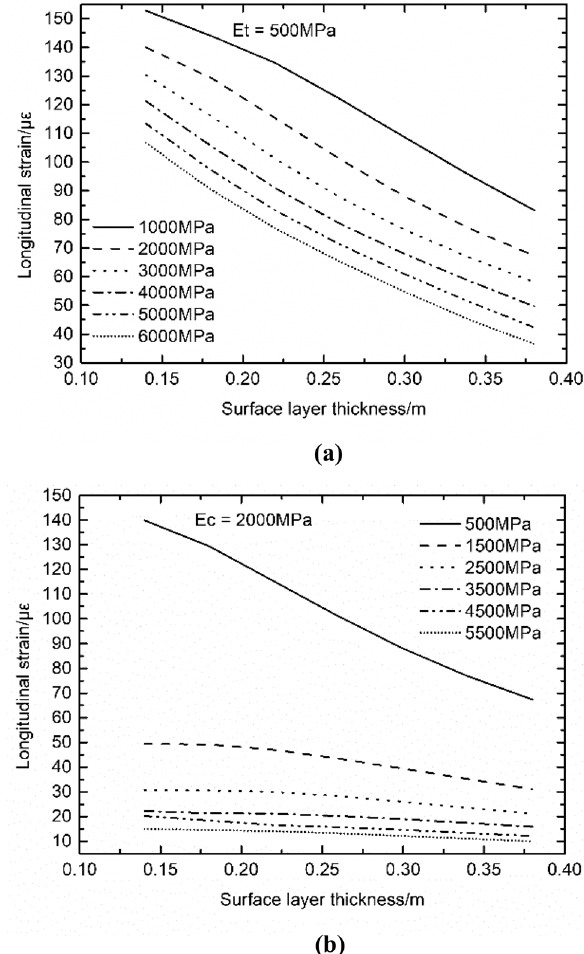
Fig. 7 Response of longitudinal tensile strain under the influence of a the thickness and modulus of the pavement (equivalent resil- ient modulus on top of the base was 500 MPa), and b the thickness of the pavement and the equivalent resilient modulus on top of the base (modulus of the pavement was 2000